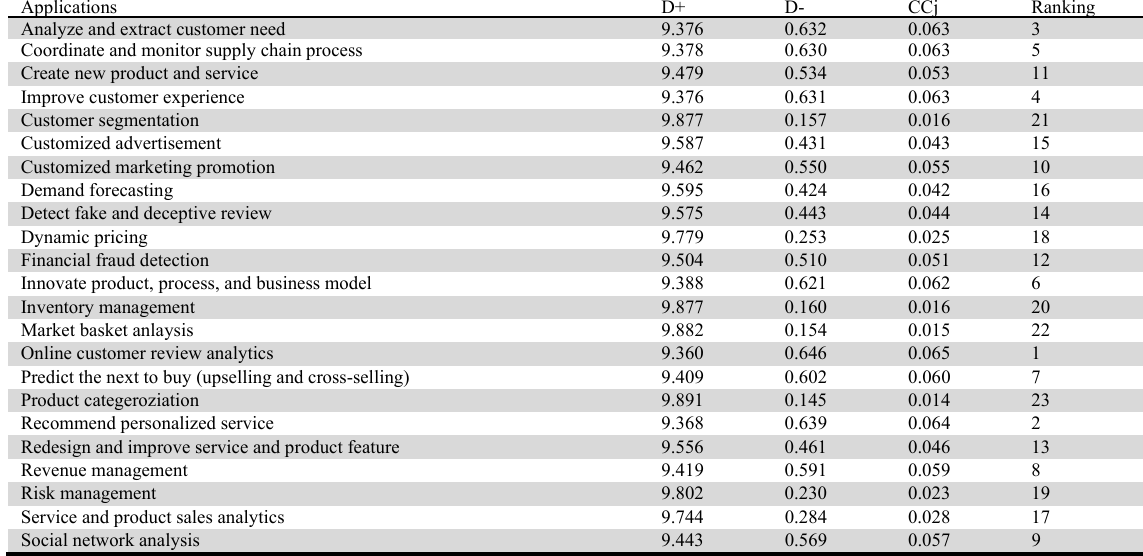
Final rankings of big data applications based on values